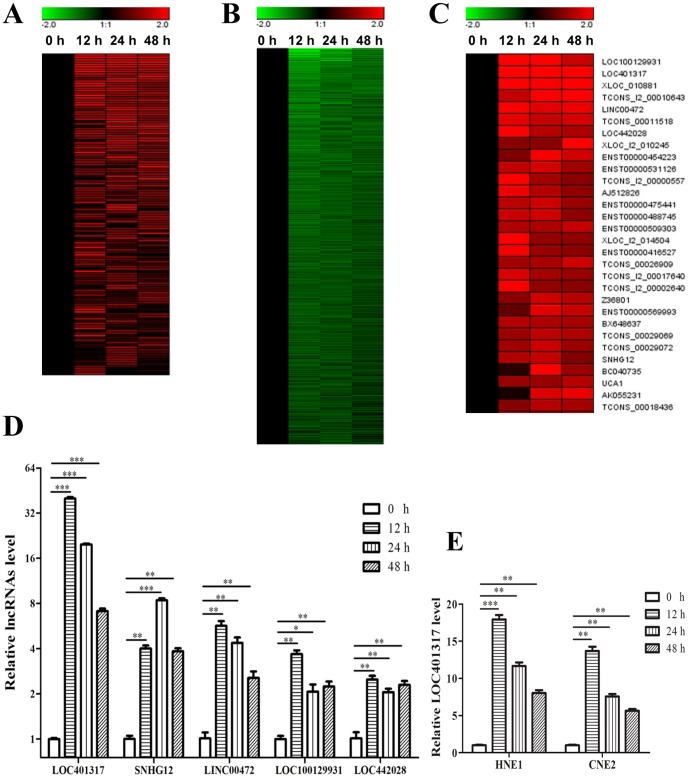
lncRNAs that are dysregulated by TP53 overexpression.(A) A total of 133 lncRNAs were upregulated in HNE2 cells by more than 2.0-fold in at least one time point (12, 24, or 48 h post-pCMV-p53 transfection), while (B) 1057 lncRNAs were downregulated by more than 2.0-fold in at least 1 time point in HNE2 cells. (C) Detailed expression profiles of the top 30 lncRNAs that were the most significantly upregulated by TP53 transgene expression. (D) Validation of 5 of the top 30 most-upregulated lncRNAs in HNE2 by qRT-PCR. Data shown reflect the means of 3 independent experiments ± S.D. *P<0.05, **P<0.01, ***P<0.001. Expression data are exhibited as normalized log ratios to control time points (0 h) for each lncRNA. (E) Validation of LOC401317 expression in HNE1 and CNE2 cells following TP53 transfection by qRT-PCR. Data shown reflect the mean of 3 independent experiments ± S.D. **P<0.01, ***P<0.001. Expression data were normalized to control time points (0 h).